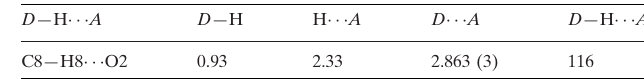
Table 2 (cid:3) – (cid:3) interactions (A˚ , (cid:2) ). Cg 1, Cg 2 and Cg 3 are the centroids of the N9–C9 A –C4 A –C5 A –C8 A , C9 A – C1–C2–C3–C4–C4 A and C5 A –C5–C6–C7–C8–C8 A rings, respectively, ccd is the distance between ring centroids, sa is the mean slippage angle (angle subtended by the intercentroid vector to the plane normal) and ipd is the mean interplanar distance (distance from one plane to the neighbouring centroid). For details, see Janiak (2000).